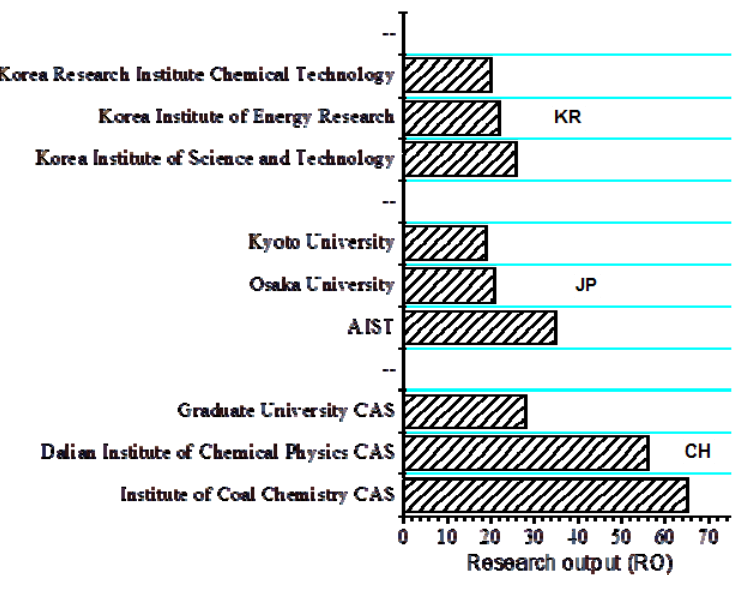
Figure 7. Distribution of R&D papers by top-nine institutions in China, Japan and